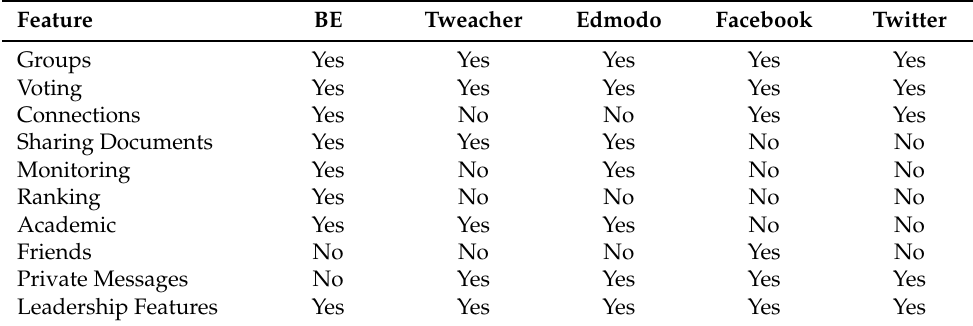
Table 2. Comparison of features across platforms.